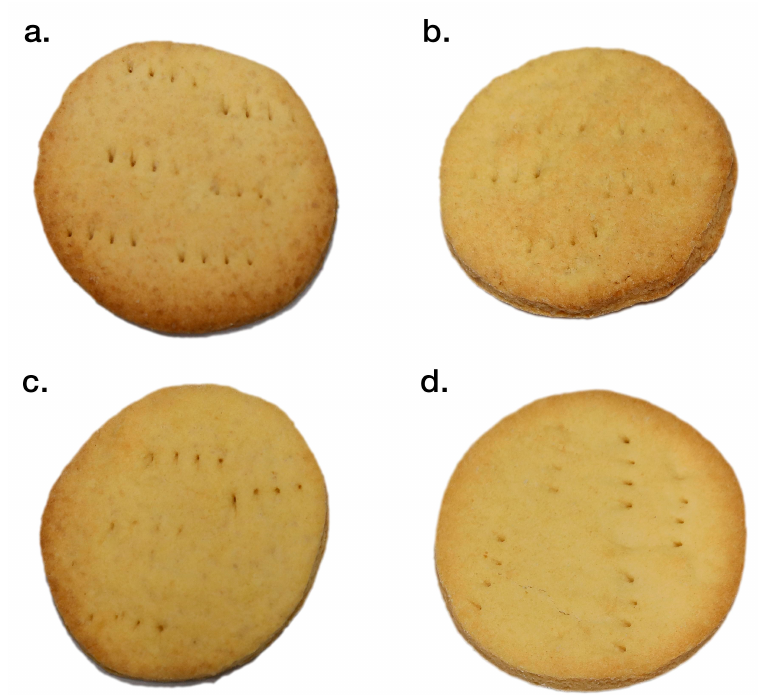
Figure 8. Wheat cookies samples prepared with ( a ) R. differens , ( b ) S. gregaria , ( c ) olive, and ( d ) sesame oils.